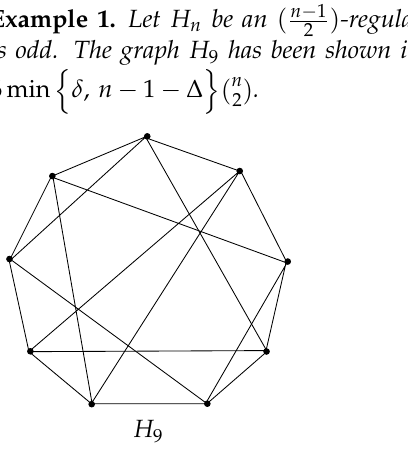
Figure 1. Graph H 9